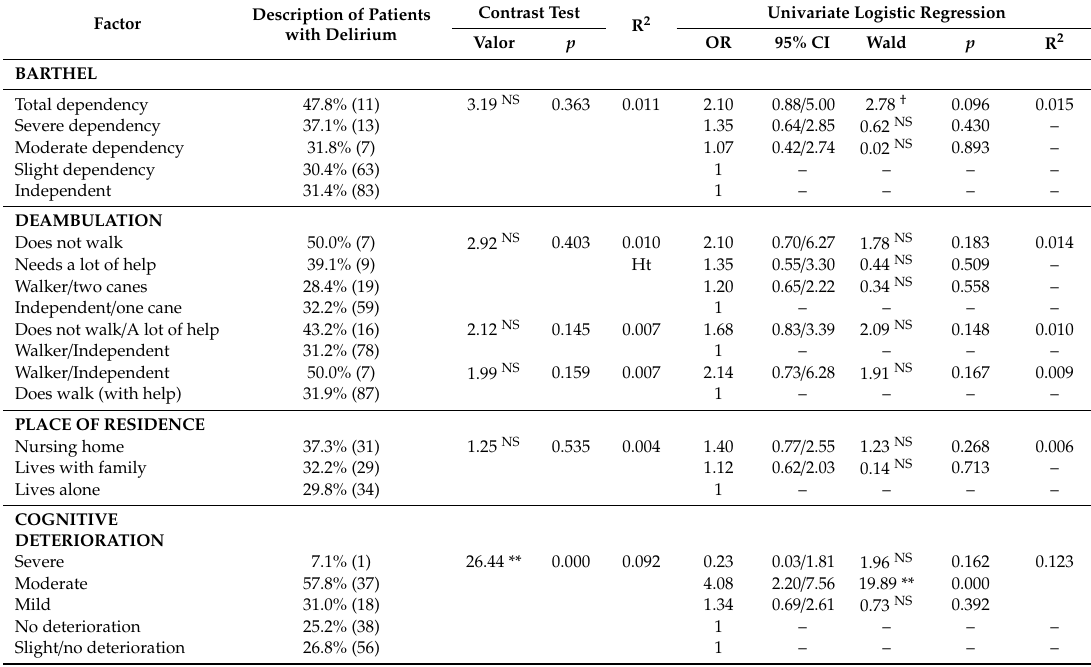
Table 1. Test of independence and univariate logistic regression. E ff ect of patient baseline factors on the presence of delirium in orthogeriatric patients with a hip fracture.